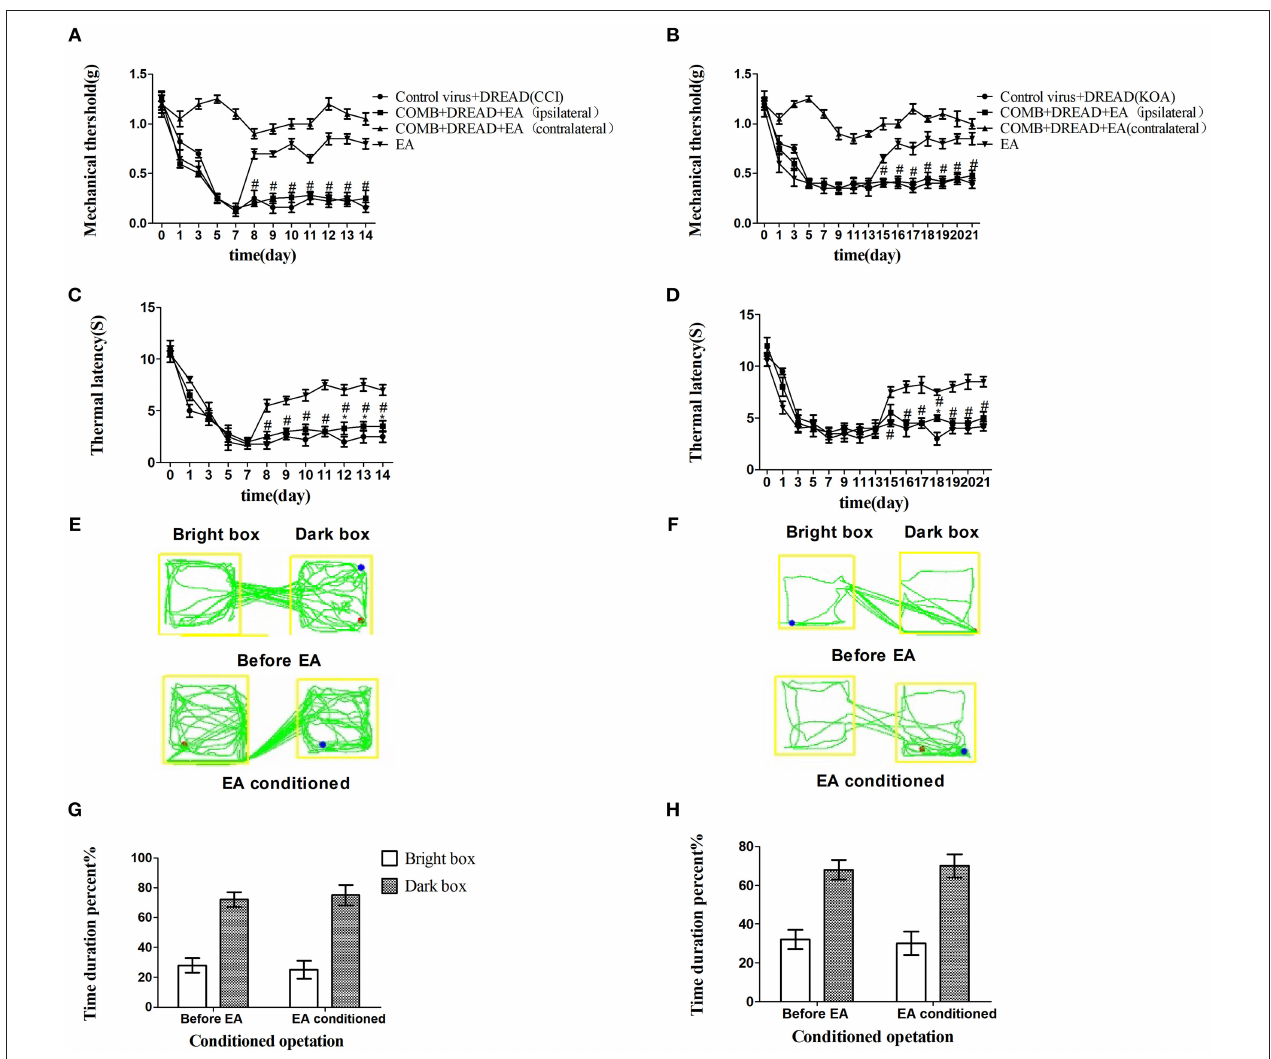
FIGURE 5 | The combination of chemogenetic activation of GABAergic neurons and chemogenetic inhibition of glutamatergic neurons in the vlPAG effectively attenuate the effect of EA. COMB is abstract of combination operation. (A,B) Time course of tactile threshold in response to von Frey filaments. (C,D) The noxious heat stimulus (53 ◦ C) caused a change in the thermal thresholds. Tactile (A) and thermal (C) withdrawal thresholds changes in CCI mice after chemogenetic activation. Changes in tactile (B) and thermal (D) withdrawal thresholds of KOA mice caused by combination operation. Motion map of combination operation of conditioning in the CPP test with CCI (E) and KOA mice (F) . G,H are summary values of motion trajectories. Virus was injected 21 days before the behavior test. CNO (1 mg/kg) and salvinorin B (5 mg/kg) were administered once a day starting from the 8th to the 14th day in the CCI model and starting from the 15th to the 21st day in the KOA model. EA (1mA and 0.1ms) at 2Hz was administered for 30min. Once a day starting from the 8th to the 14th day in the CCI model and starting from the 15th to the 21st day in the KOA model, all behavior tests were completed 2h after CNO administration. Control groups consisted of CCI or KOA mice injected with control virus and DREAD but without EA treatment. Data are expressed as means ± SEM ( n = 12 in each group). In A–D , * p < 0.05, compared with control group; # p < 0.05, compared with the model group; In G,H ,* p < 0.05, compared with the bright box time duration percent before combination operation; # p < 0.05, compared with the dark box time duration percent before combination